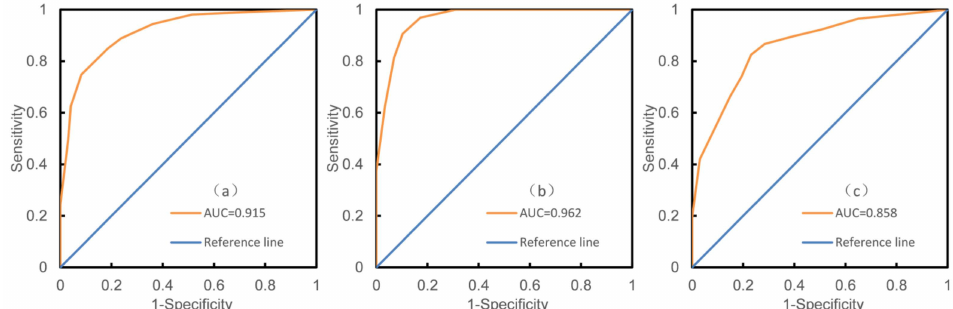
Figure 6. The ROC curves based on the training dataset: ( a ) of the model for Beichuan County; ( b ) of the model for Yanzi River Basin; ( c ) of the unified model.